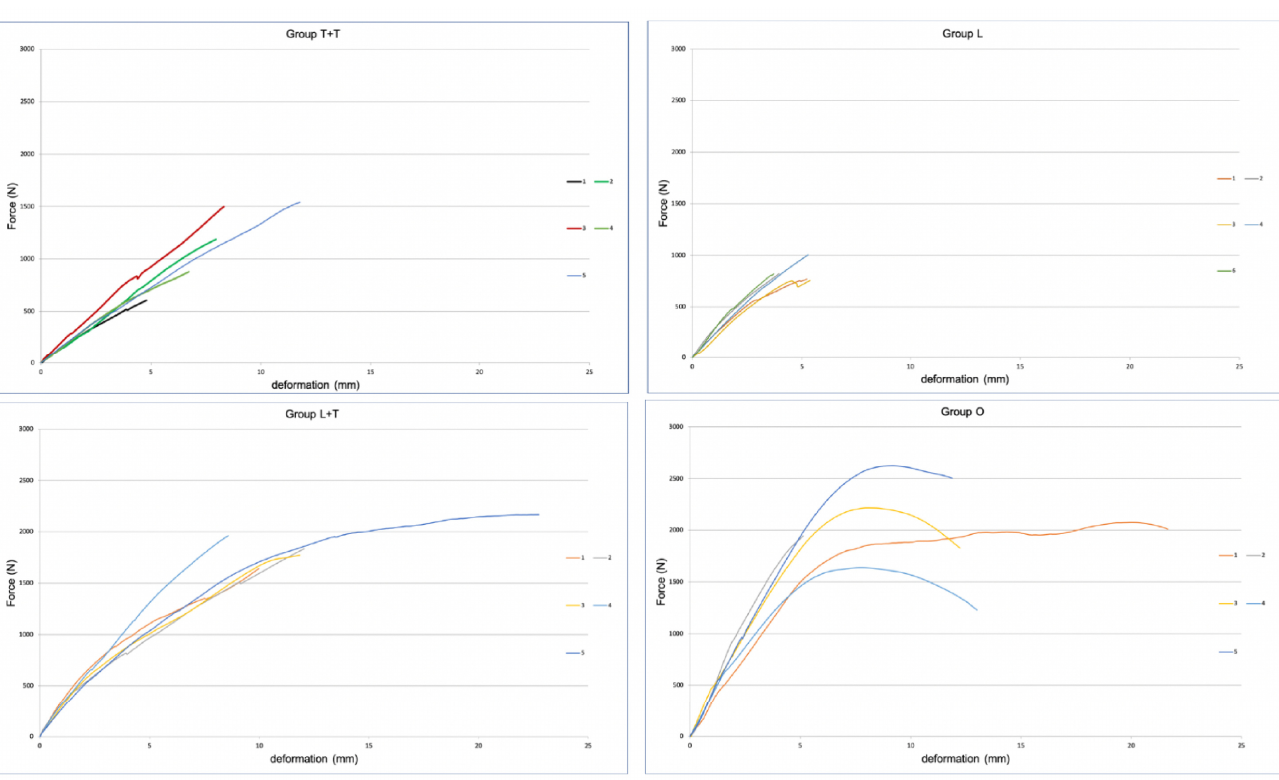
Fig 3. Stiffness (N/mm) of the bone models per group calculated from the slope of the linear regions of the force/displacement curves. A. Group T+T: two non- locking one-third tubular plates positioned at right angles; B. Group L: locking anatomic plate positioned on the lateral surface of the humerus; C. Group L+T: two perpendicular plates, one locking and one one-third tubular; D. Group O: control.